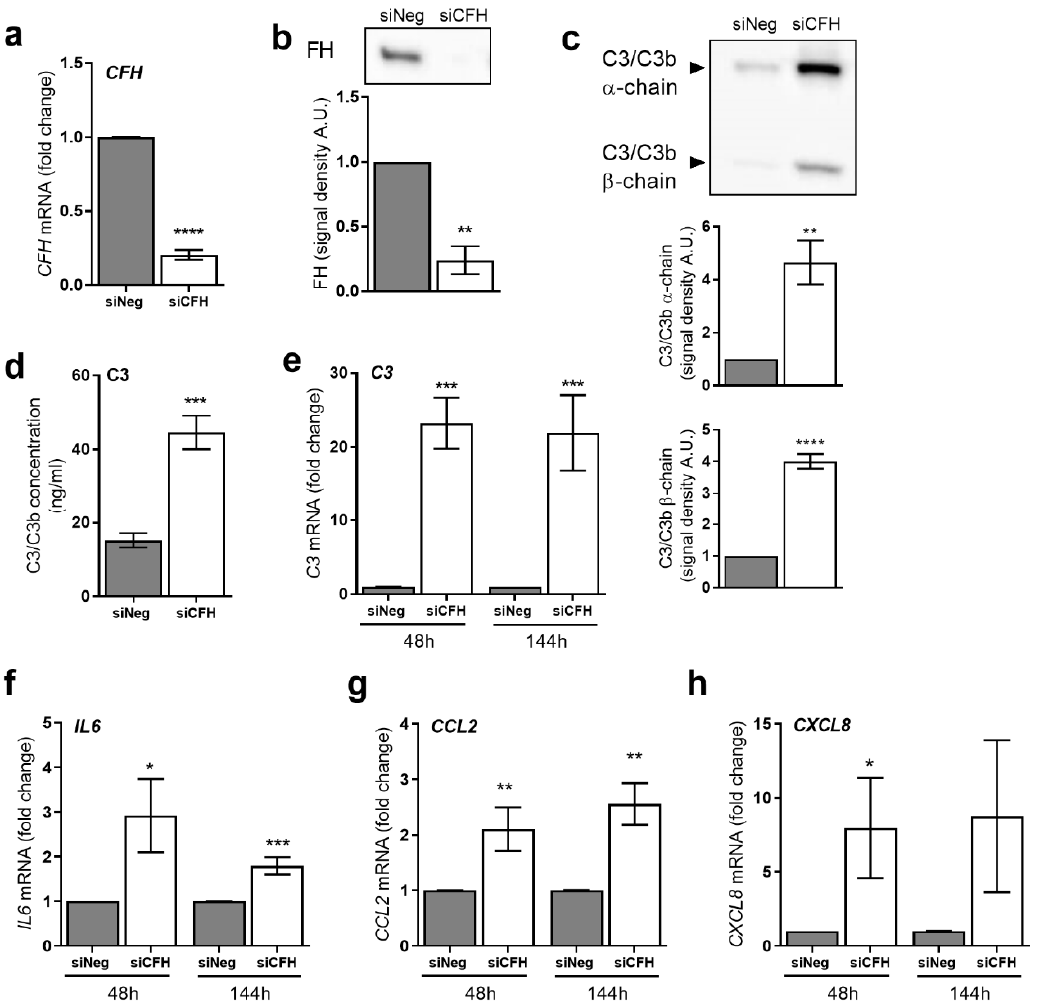
Figure 1. Short and sustained FH reduction leads to increased expression levels of C3 and inflammatory cytokines. ( a ) Evaluation of CFH expression after 144 h by qRT-PCR analyses. Data are normalized to the housekeeping gene PRLP0 using ∆ ∆ Ct methods. SEM is shown, n = 5. ( b ) Western blot analyses of FH protein levels in cell culture supernatants of hTERT-RPE1 cells after 144 h. Quantification of the signal density of three independent experiments is shown. ( c ) Western blot analyses of C3/C3b α -chain and β -chain protein levels in cell culture supernatants of hTERT-RPE1 cells after 144 h. Quantification of the signal density of five independent experiments is shown. ( d ) C3/C3b ELISA analyses of cell culture supernatants of hTERT-RPE1 cells after 144 h. SEM is shown, n = 6. ( e,h ) Monitoring of gene expression by qRT-PCR analyses in hTERT-RPE1 cells: ( e ) Complement component 3 ( C3 ), ( f ) interleukin-6 ( IL6 ), ( g ) C-C Motif Chemokine Ligand 2 ( CCL2 ) and ( h ) interleukin-8 ( CXCL8 ). Data are normalized to housekeeping gene PRPL0 using ∆ ∆ Ct method. SEM is shown, n = 5 − 8. Western blot images were cropped, and full-length blots are provided in Supplementary Material. Significance was assessed by a Student’s t -test. * p < 0.05, ** p < 0.01, *** p < 0.001, **** p < 0.0001. negative control (siNeg), CFH specific siRNA (siCFH).